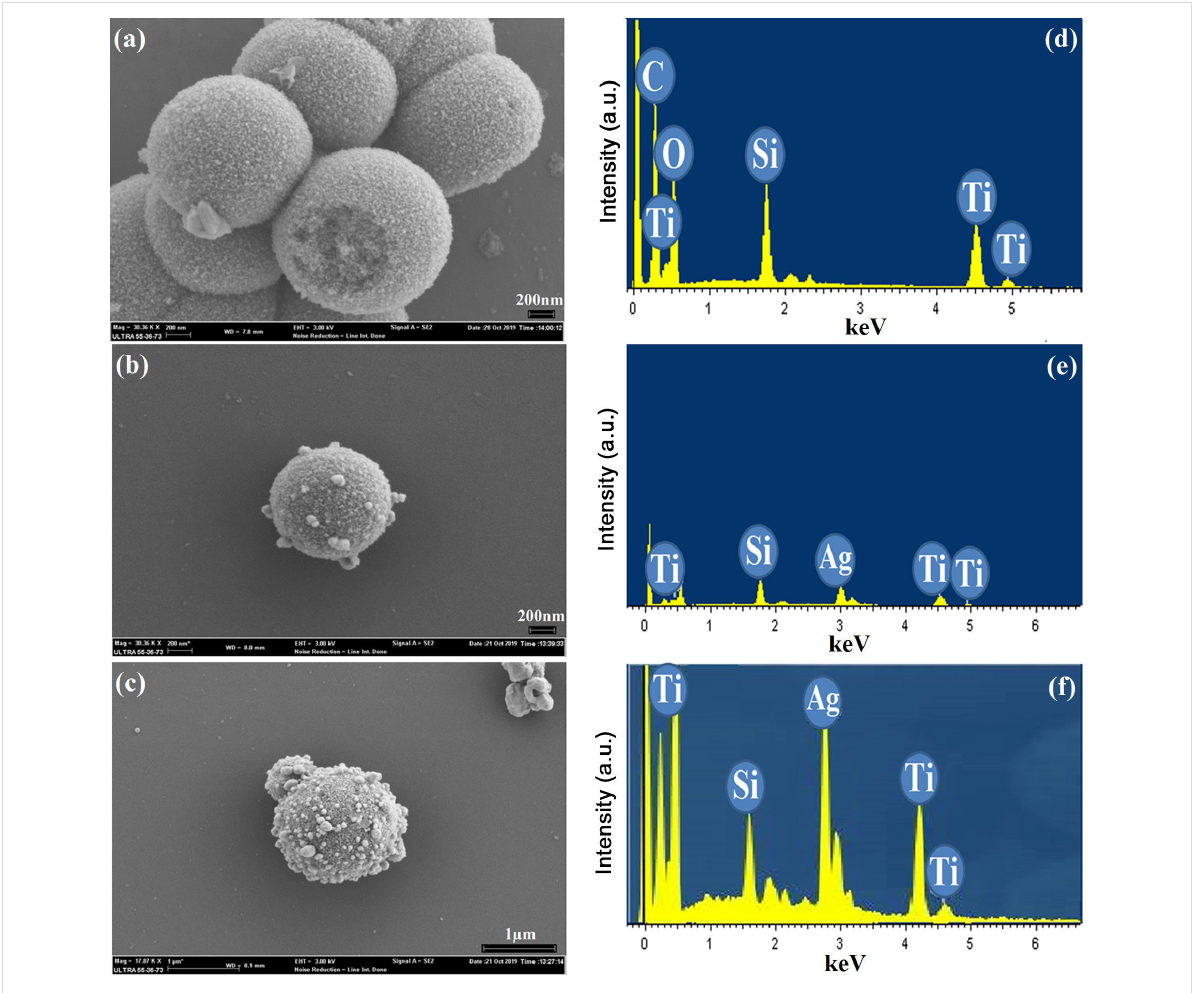
Figure 2: SEM and EDS images of the synthesized splat-shaped nanoparticles: (a) pure TiO 2 NPs, (b, c) Ag–TiO 2 nanocomposites with different Ag content. (d, e, f) are the respective EDS spectra. Scale bars are 200 nm (a, b) and 1 µm (c).